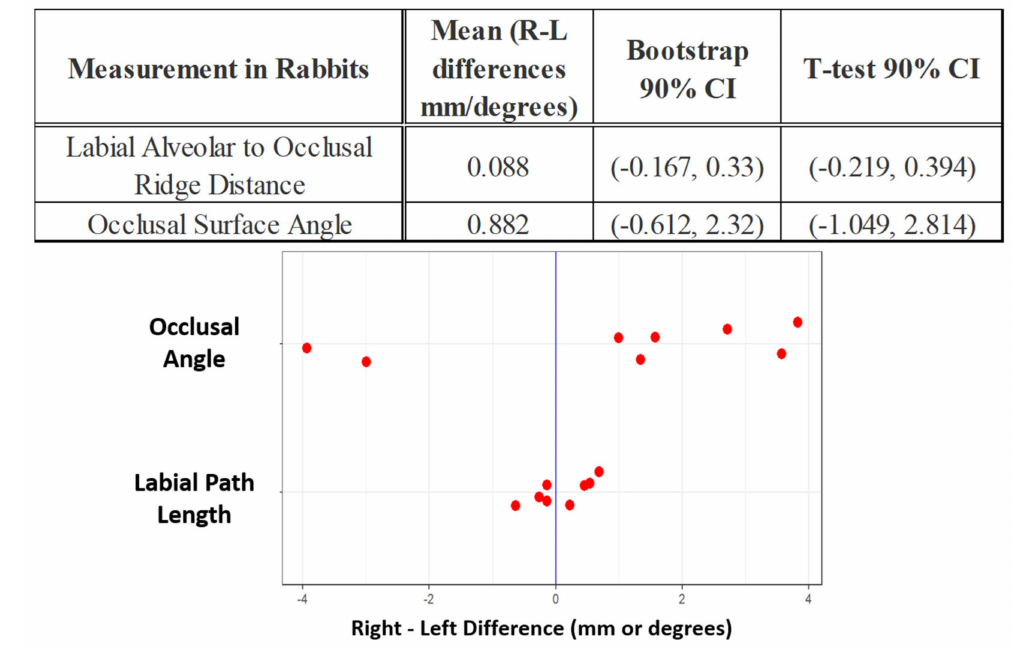
Figure 8. Difference between right and left rabbit incisors at baseline with 90% confidence intervals. The dots in the plot below describe the left-right differences of individual rabbits in the two different measures. } Note that the vertical positions of the data points within each measurement category allows for better visualization of data but carry no meaning.